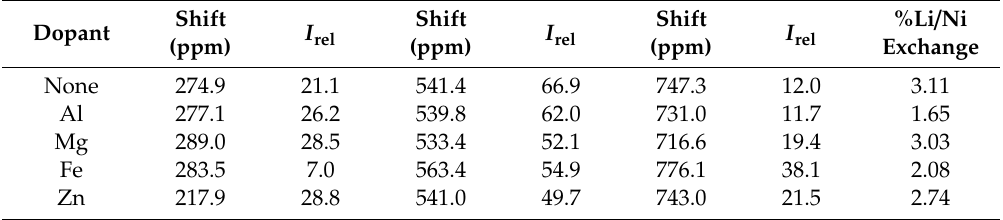
Table 2. Deconvolution of sample spectra. Calculated areas include all significant sideband